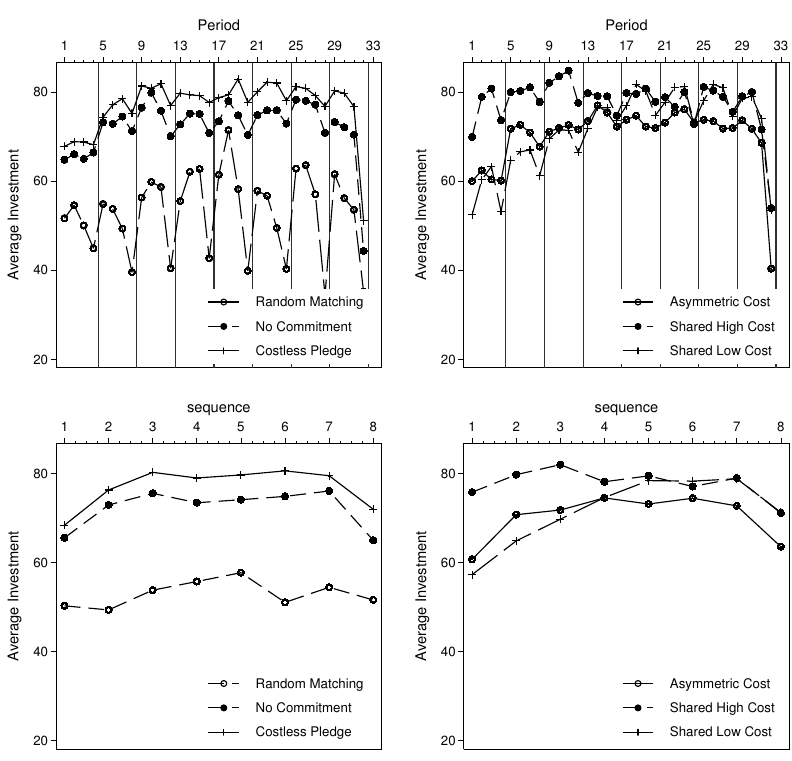
Figure 2. Average individual contributions by treatment.